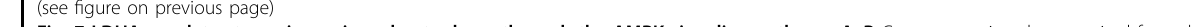
Fig. 7 LDHA regulates tumorigenesis and autophagy through the AMPK signaling pathway. A , B Gene expression data acquired from the TCGA database were subjected to GSEA v2.2.0; the results showed that LDHA expression was correlated with AMPK signaling and autophagy-related pathways. C , D The ADP/ATP ratio assay showed that LDHA knockdown increased the ADP/ATP ratio in B-CPAP cells, whereas overexpression of LDHA decreased the ADP/ATP ratio in KTC-1 cells. E – G Western blotting was used to detect phosphorylated AMPK, phosphorylated mTOR, phosphorylated ULK1, p62, and LC3BII/I in B-CPAP cells treated with LDHA knockdown or FX11 (10 μ M for 24 h) and in KTC-1 cells treated with LDHA expressing. Colony formation assay H and CCK-8 assay I showed that AMPK knockdown partially attenuated the inhibited proliferation induced by LDHA knockdown in B-CPAP cells. J Flow cytometry indicated that AMPK knockdown partially reversed the apoptosis induced by LDHA knockdown in B-CPAP cells. K B-CPAP cells stably knocking down LDHA were infected with siRNAs targeting AMPK. Western blotting was used to detect phosphorylated AMPK, phosphorylated mTOR, phosphorylated ULK1, p62, and LC3BII/I expression levels. The data are presented as the mean ± SD. All * p < 0.05, ** p < 0.01, *** p <